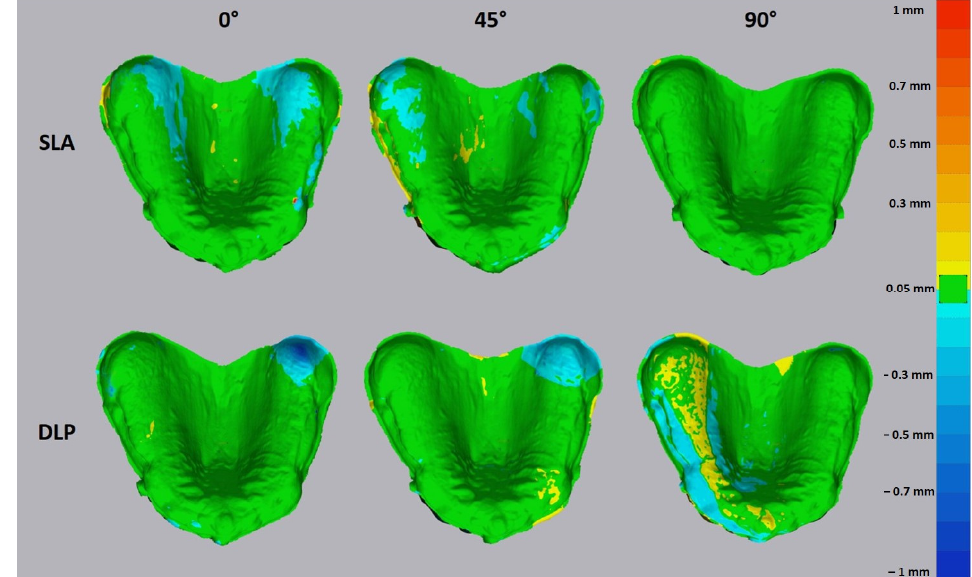
Figure 9. The heat map for the precision of 3D printed denture bases. The tolerance level was set to ±0.05 mm. The yellow to red deviation shows the positive deviations and cyan to blue, negative.